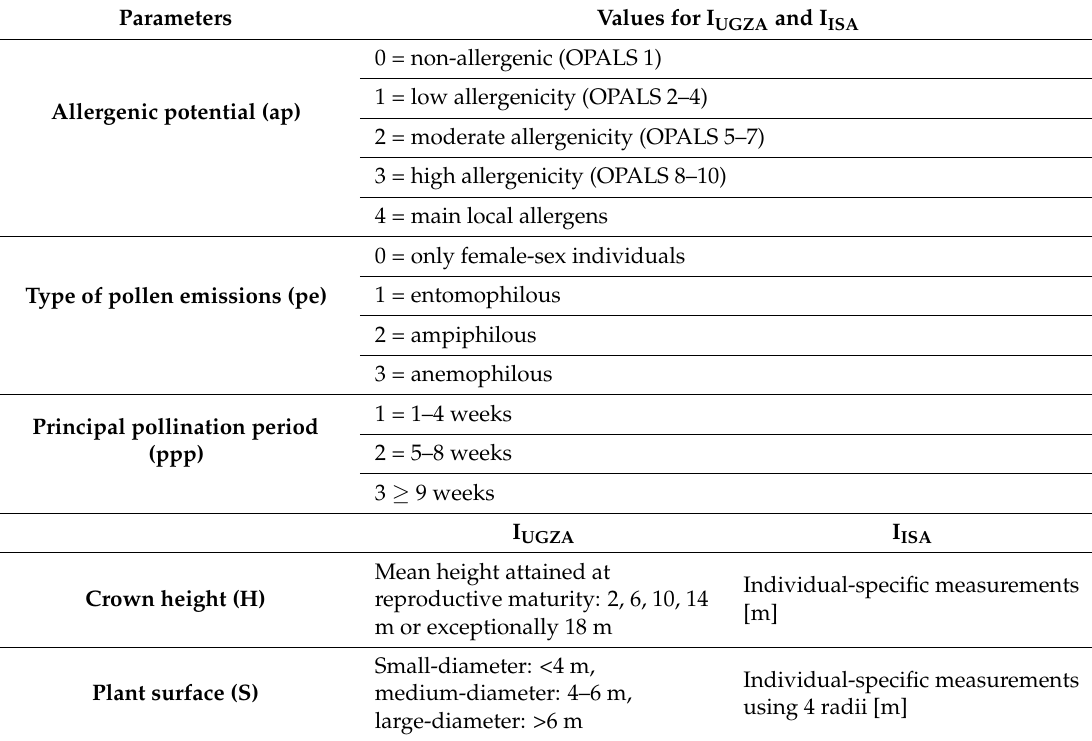
Table 2. Scale of values for the parameters used for I UGZA (Urban Green Zone Allergenicity Index) and I ISA (Index of individual-specific allergenic potential of green